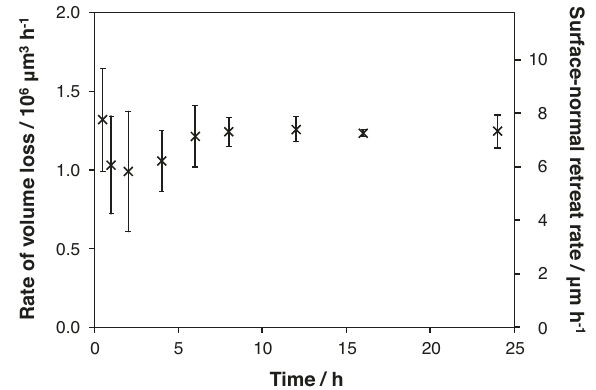
Fig. 2 Rates of volume loss and surface-normal retreat as a function of reaction time. The volumes refer to a basal area of 412 µm × 412 µm. Data are given as mean values ± standard devia- tions for three independent experiments per time of